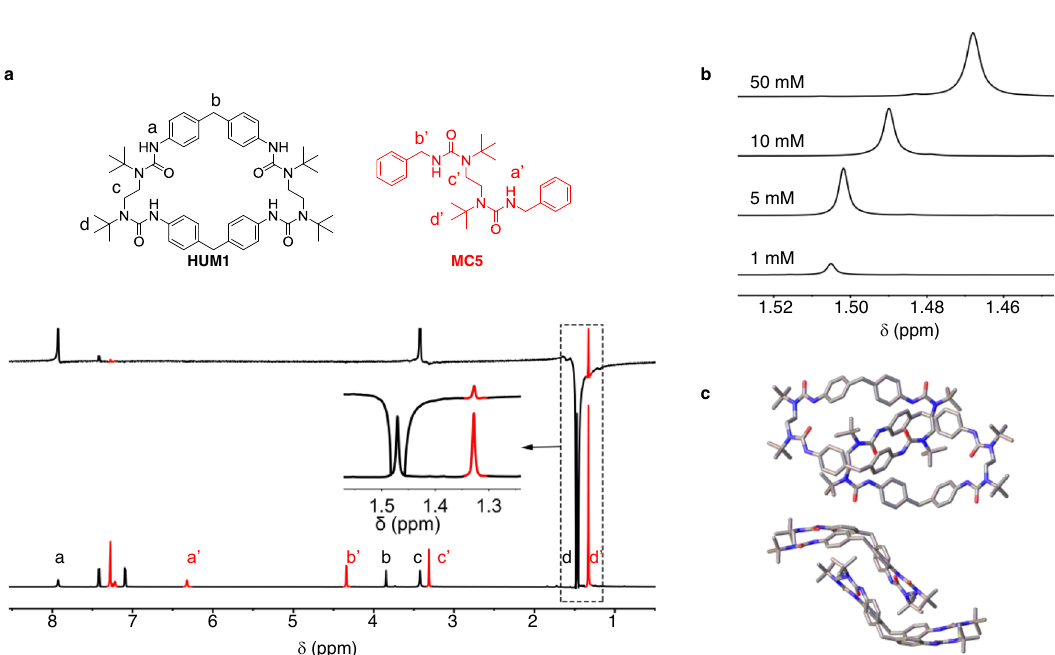
Fig. 4 Role of t- Bu group in thermodynamic stabilization. a Upper: structure of HUM1 and the acyclic model compound MC5 used in the NOE experiment. Lower: NOESY showing the spatial proximity between HUM1 (black) and MC5 (red) protons (750 MHz, CDCl 3 , HUM1 25 mM, MC5 50 mM); when irradiating the t -Bu group in HUM1 , MC5 showed NOE peaks. b Concentration-dependent NMR of HUM1 ; peak for t- Bu group shifted up fi eld while other peaks showed no clear change. c Top and side view of HUM1 from the single-crystal XRD; t- Bu group sits right inside the pocket. Color code: gray, C; blue, N; red,